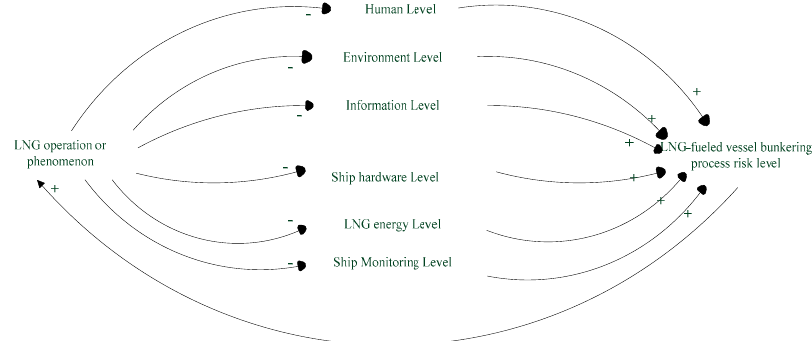
Figure 2. Causal relationship flow graph in the complex operation system.